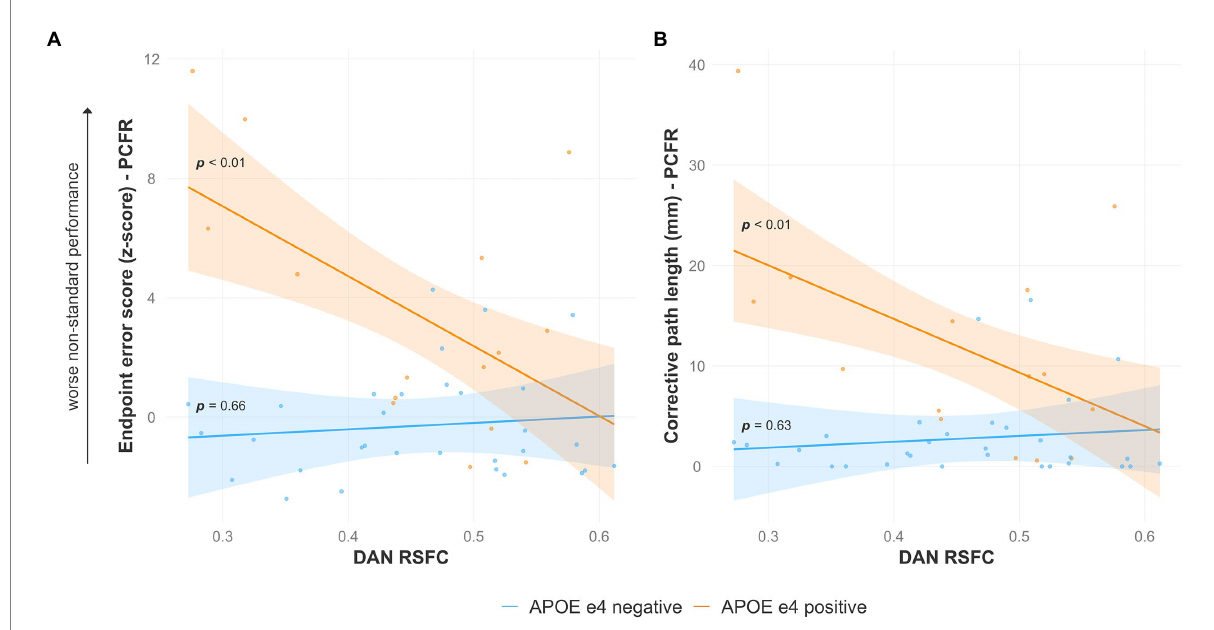
FIGURE 5 Lower intra-DAN mean RSFC predicts worse visuomotor performance in the plane-change feedback reversal condition only in APOE ε 4 carriers. Worse non-standard visuomotor performance is reflected by (A) higher endpoint error scores, and (B) greater corrective path lengths. Significant results shown from multiple regression and simple slopes analyses. RSFC, resting state functional connectivity; APOE , apolipoprotein E; DAN, dorsal attention network; PC + FR, plane change feedback reversal